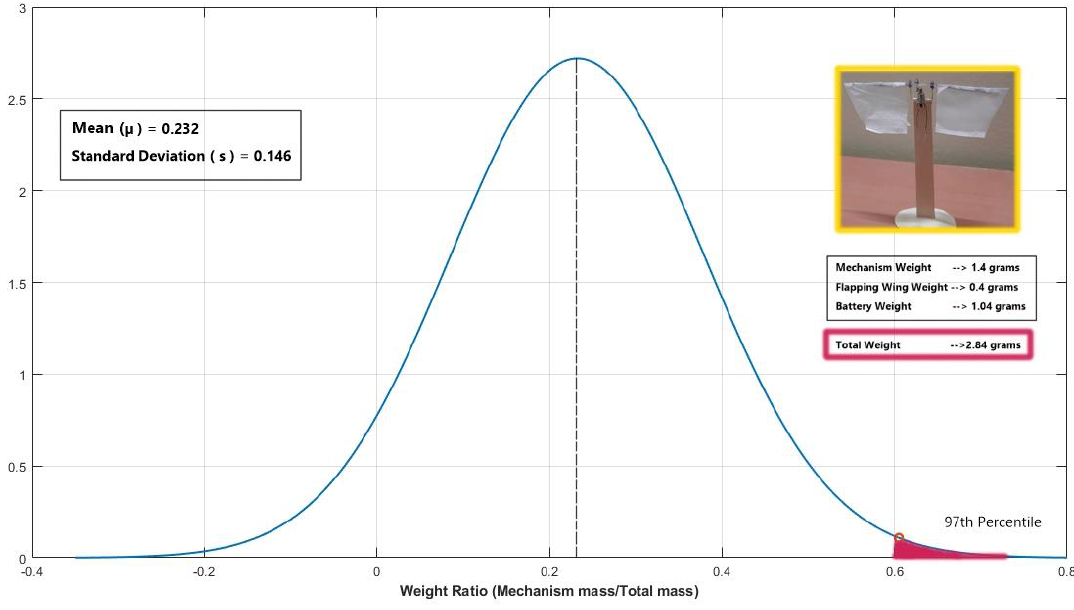
Figure 28. Normal Distribution comparison of the proposed design −II configuration’s metric against the existing flapping wing design weight ratio metric. the existing flapping wing design weight ratio